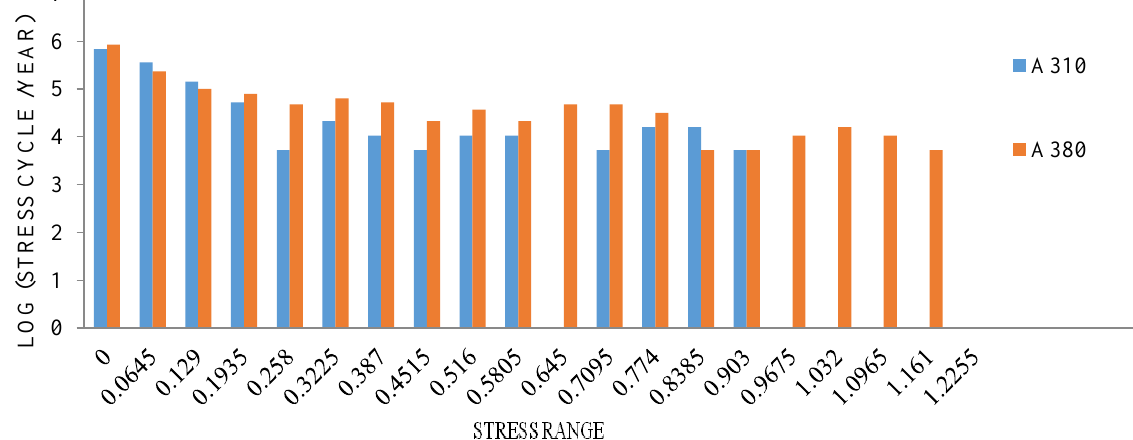
Fig. 13. Histogram for Stress ranges vs. Frequency (cycles/year) A-310 and A-380